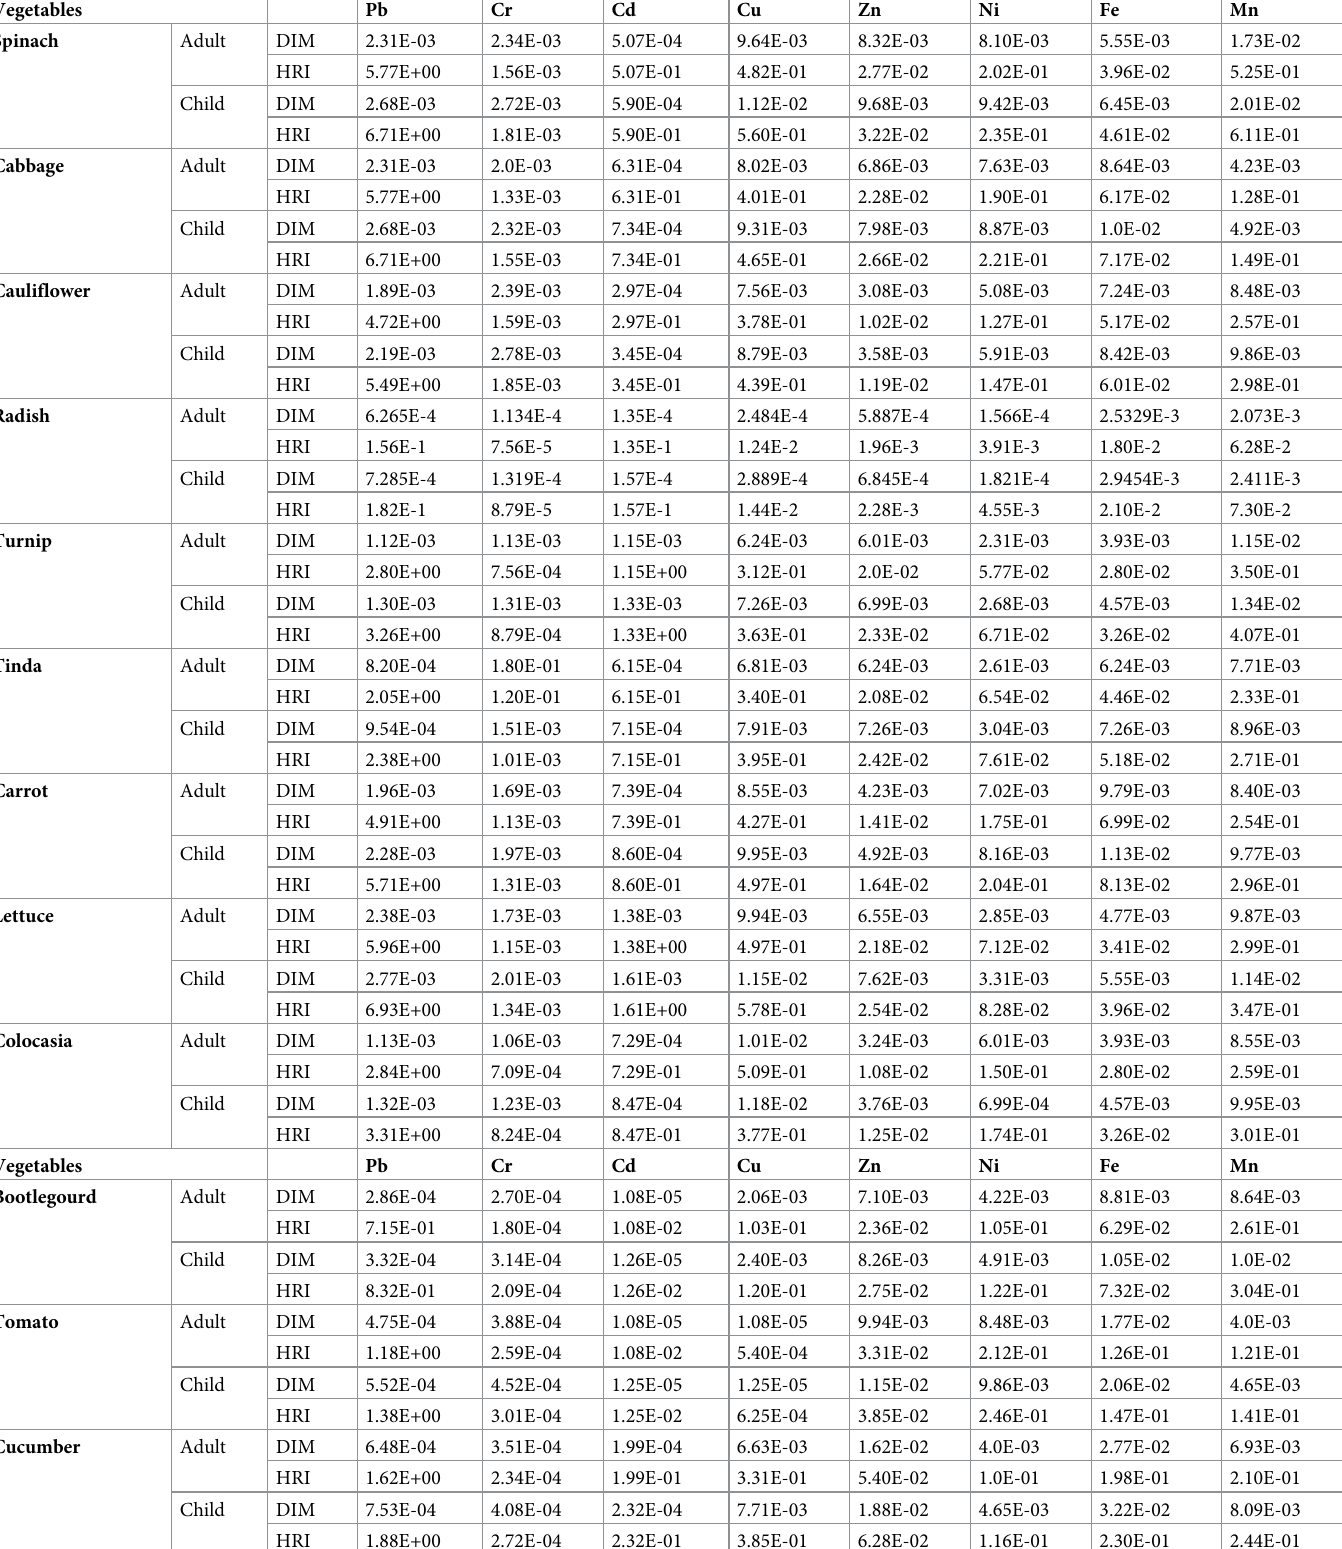
Table 7. DIM and HRI for fresh water irrigated vegetables of district Swabi.